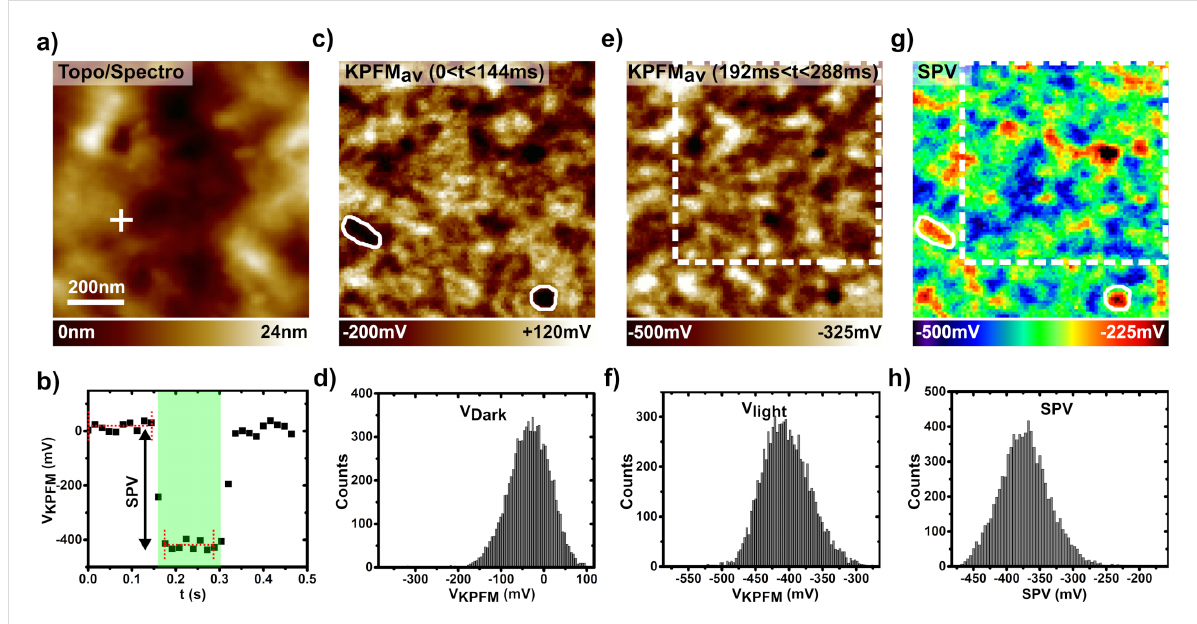
Figure 8: (a, c, e, g) nc-AFM/KPFM images of the PTB7:PC 71 BM blend (1 μ m × 1 μ m, 90 × 90 pixels) acquired during a differential SPV imaging ex- periment ( P opt = 18.5 mW ∙ cm − 2 ). (a) Topographic image. (b) Spectroscopic curve of the KPFM potential as a function of time (30 pixels, each 6 ms long), recorded at the location indicated by a cross in (a). The dark-state SP and SP upon cw illumination are calculated by averaging the data points for 0 < t < 144 ms and 192 < t < 288 ms, respectively. These time windows are highlighted by red dotted lines. (c) Calculated dark-state SP ( V dark ) image. (d) Histogram of the V dark values. (e) Calculated image of the SP under illumination ( V light ). (f) Histogram of the V light values. (g) Calculated image of the SPV. (h) Histogram of the SPV values. The white solid contours in (c) and (g) highlight the existence of strong correlations between the contrast in the dark-state potential and the SPV images. The dotted rectangles in (e) and (g) indicate the sample area highlighted in Figure 9a–c and displayed in Figure 9e–g.